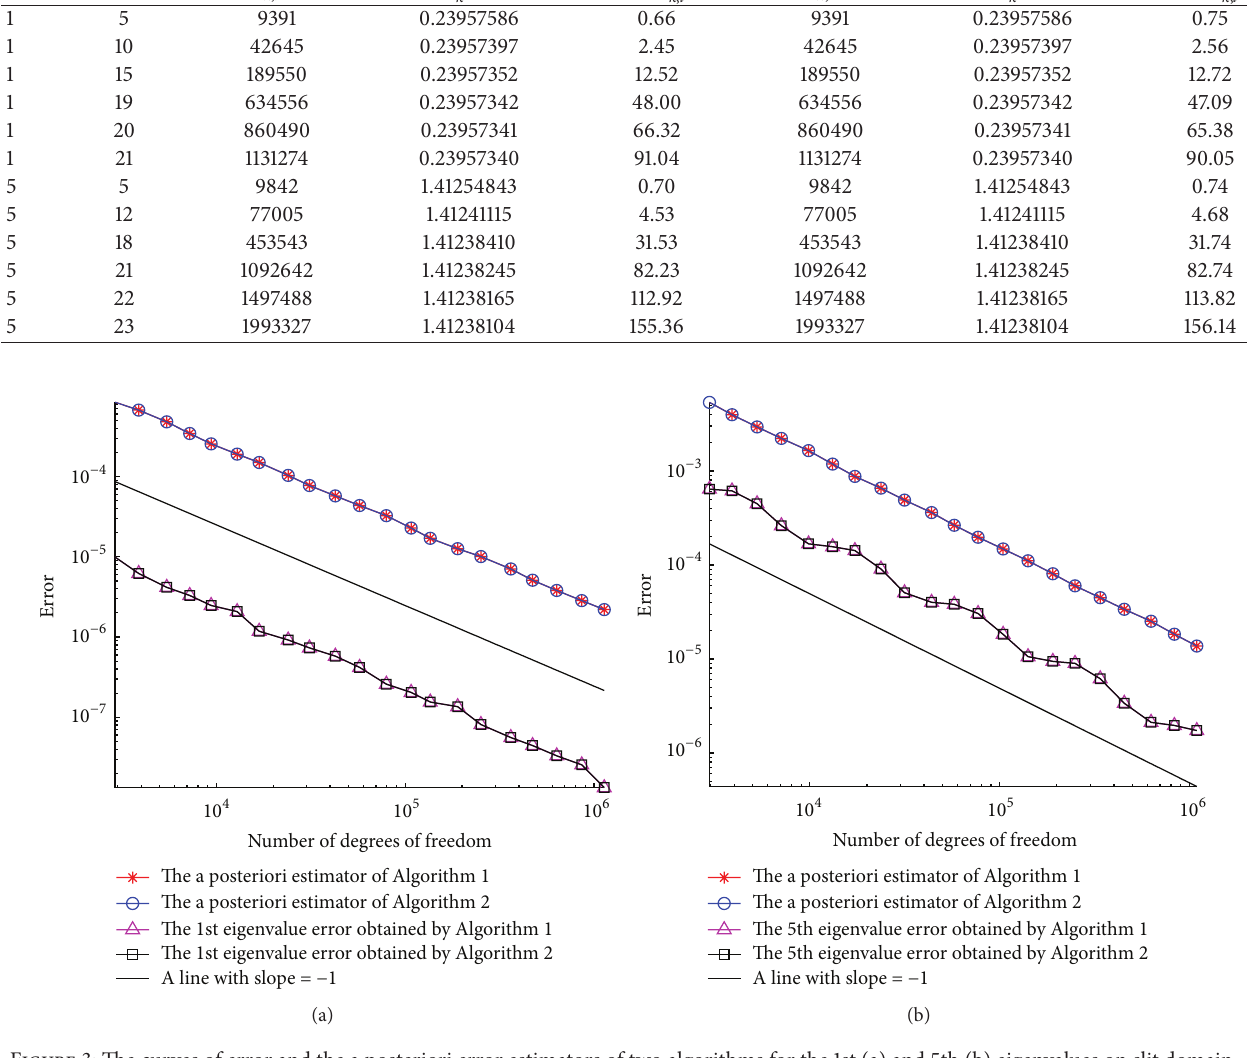
Figure 3: The curves of error and the a posteriori error estimators of two algorithms for the 1st (a) and 5th (b) eigenvalues on slit